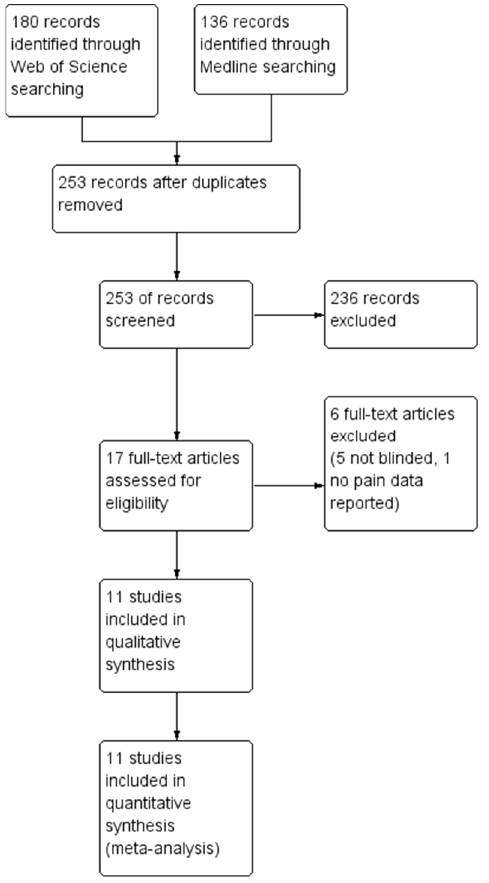
Figure 1. Modified PRISMA flow diagram of study